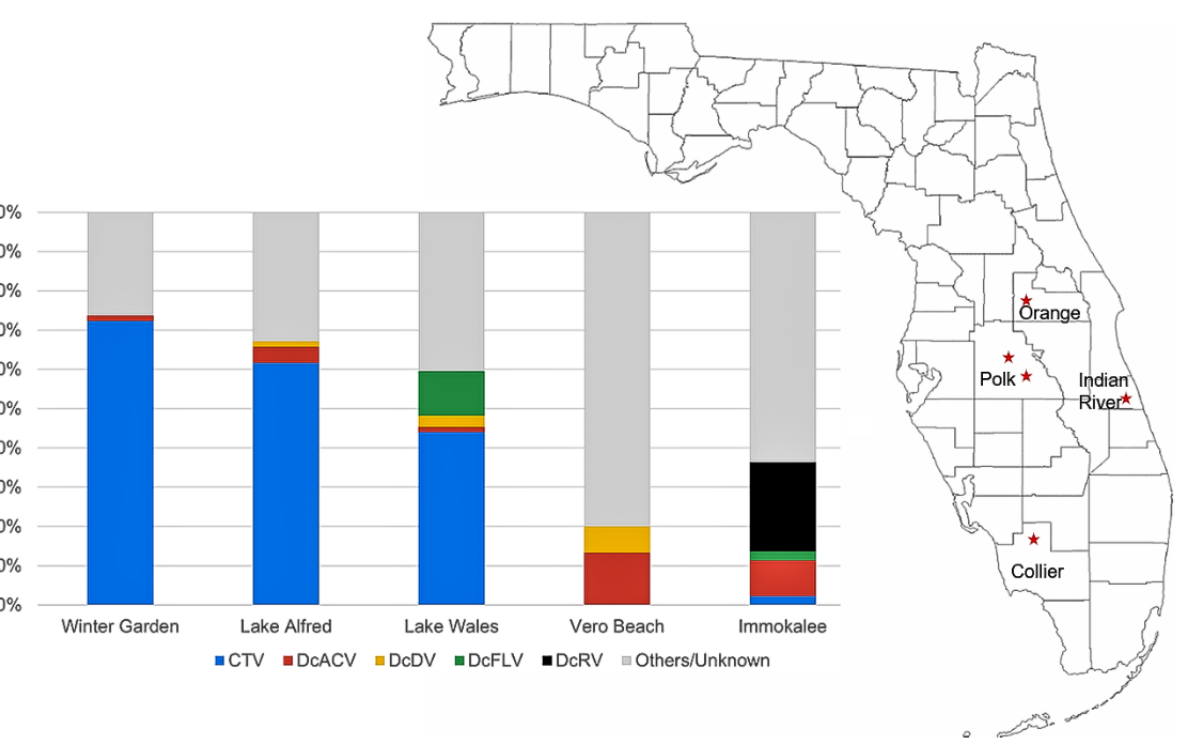
Figure 1. The percentage of viral sequence reads found in the HTS analysis of psyllid guts from each citrus production region in Florida. The composite sample represents the sequences that matched to known insect or plant virus species or unknown viruses.